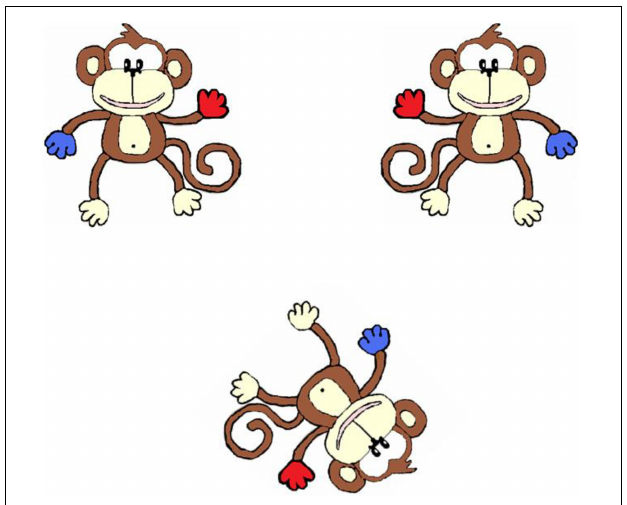
FIGURE 1 | Example mental rotation